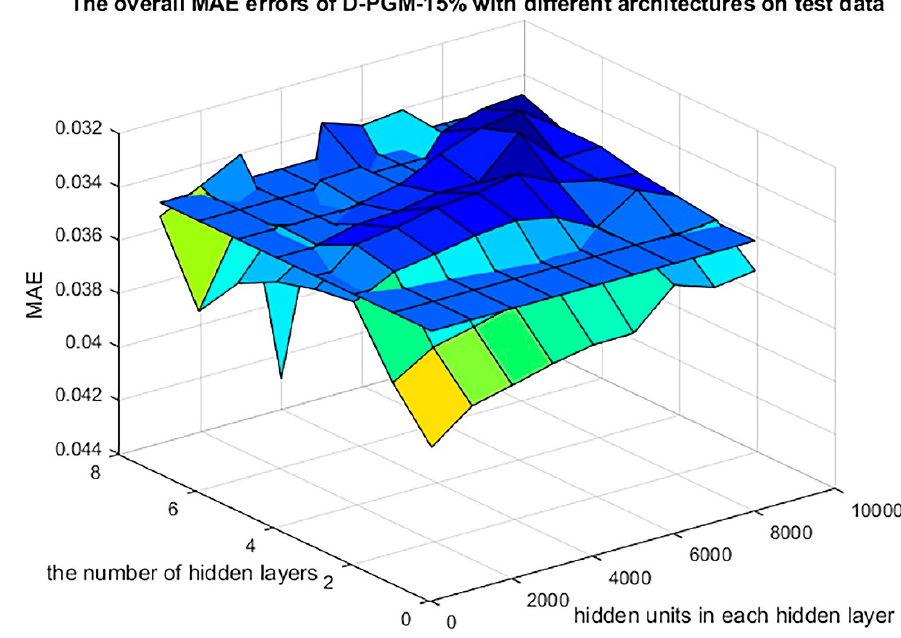
Figure 3. The overall MAE errors of D-GPM-15%, with various architectures for the MBV-te. The overall MAE errors of SVM for the MBV-te are shown as a cross section, which is 0.0350 high in terms of the MAE and serves as a benchmark to evaluate the MAE of D-GPM-15% with various architectures.